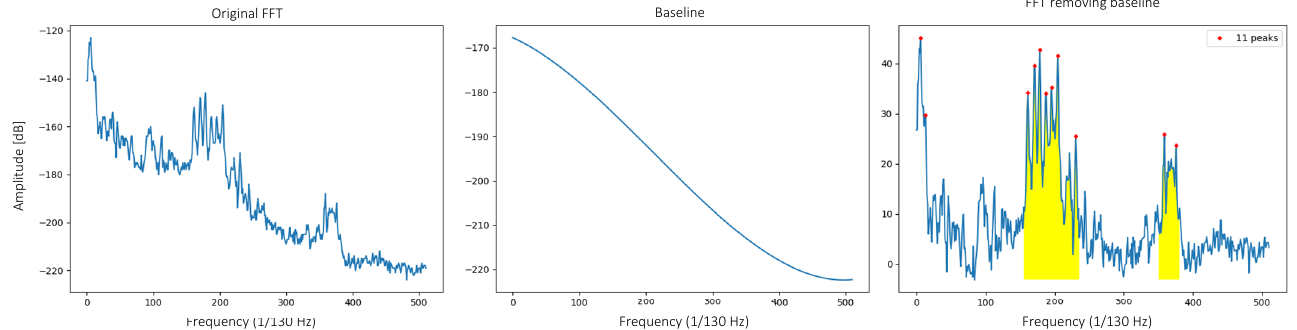
Figure 17. Graphs of the different phases of the identification process, from the original FFT, to the FFT without the base noise, with the detected peaks and the colored areas of interest.